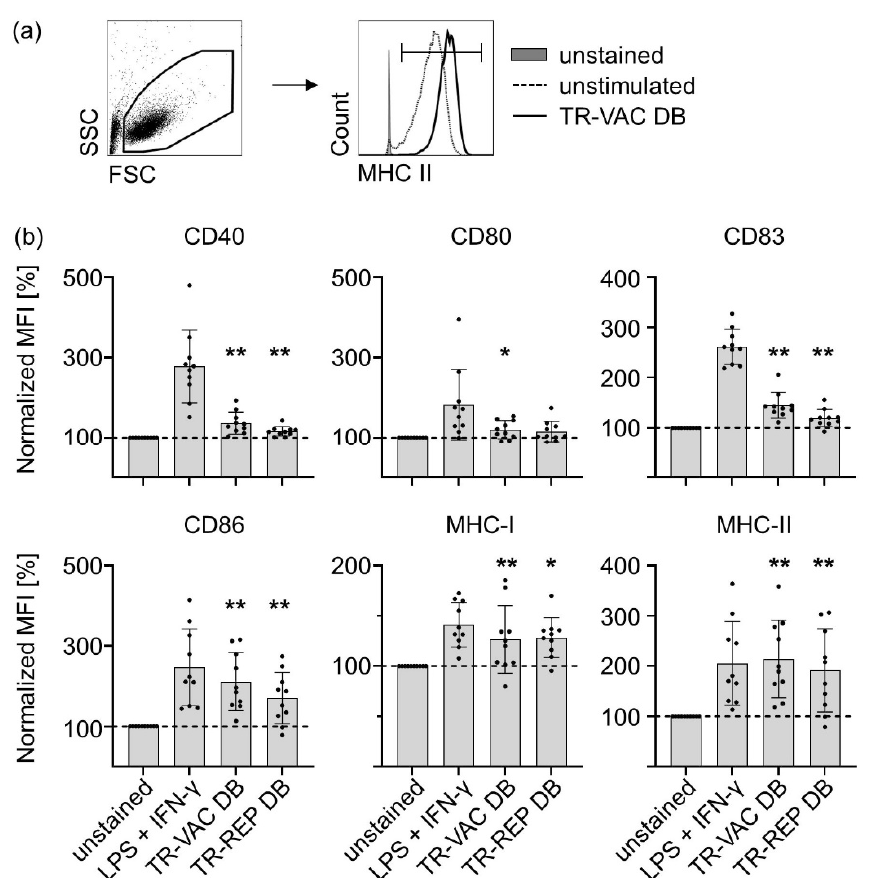
Figure 5. Stimulation of human DC with TR-VAC. Human monocyte-derived DCs were stimulated with TR-VAC DB or TowneUL130rep-ΔGFP DB (TR-REP DB; 10 µg/5 × 10 5 DC), 1 µg/mL LPS plus 100 U/mL IFN-γ as positive control, or left untreated (Ø) for 24 h. Subsequently, cells were harvested and stained with α-CD40-PacificBlue, α-CD80-APC, α-CD83-FITC, α-CD86-PE, α-MHC-I (HLA-ABC), and α-MHC-II (HLA-DR)-APC-Cy7 antibodies for flow cytometric analyses. ( a ) Representative FACS-analyses of MHC II-expression for one donor is given comparing unstained (gray-shaded histogram), unstimulated (dashed line), and TR-VAC DB-stimulated (black line) DC (peaks normalized to mode). ( b ) Statistical analyses of marker-expression as indicated and described (n = 10). Expression-levels were normalized to the MFI of untreated cells (dashed line). Statistical analysis was performed using Wilcoxon’s matched-pairs signed-rank test. *, p < 0.05; **, p < 0.01; mean value plus SD.